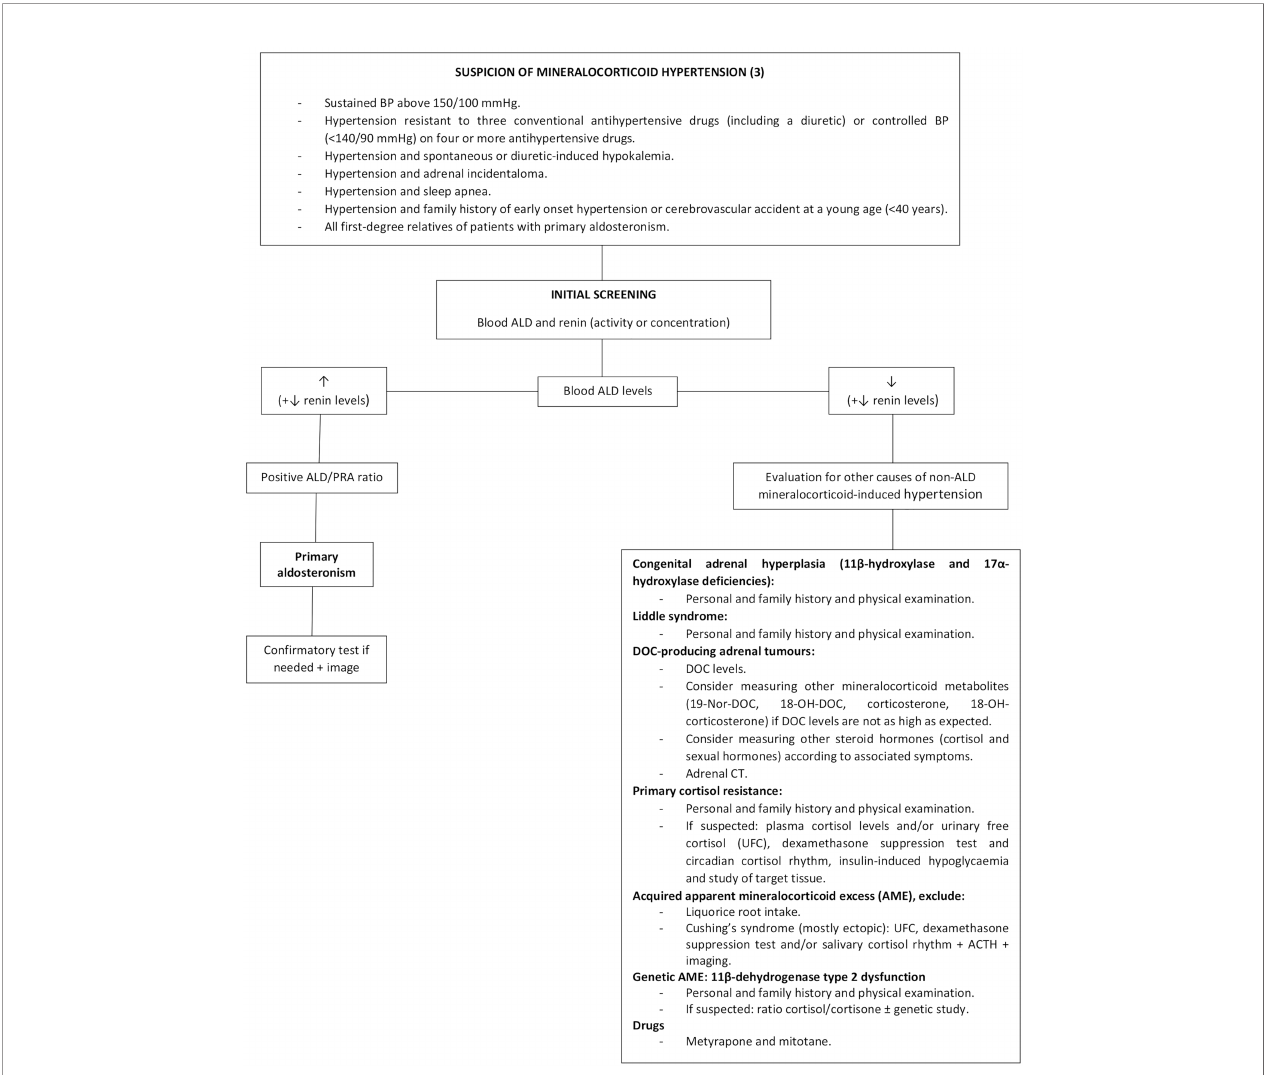
FIGURE 6 | Algorithm for the diagnostic approach of patients with non-ALD-dependent mineralocorticoid hypertension. BP, blood pressure; ALD, aldosterone; PRA, plasma renin activity; DOC, 11-deoxycorticosterone; 19-Nor-DOC, 19-Nor-deoxycorticosterone; 18-OH-DOC, 18-hydroxy-deoxycorticosterone; CT, computed tomography; ACTH, adrenocorticotropic